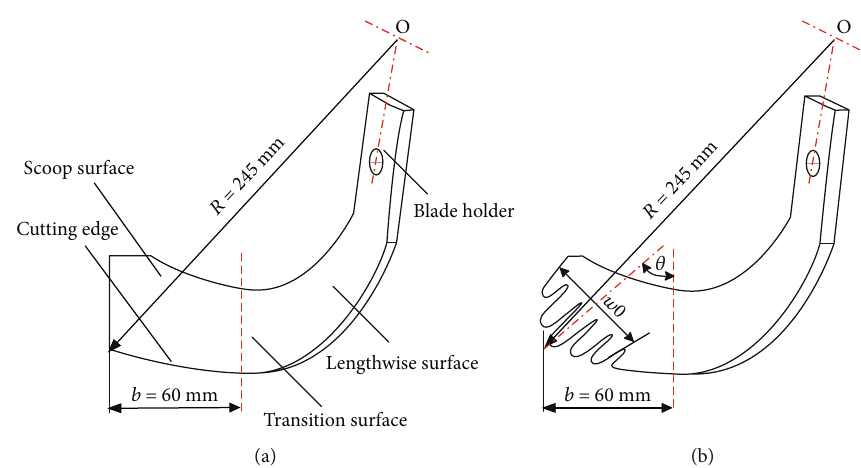
Figure 5: Con fi gurations of rotary tillage blades: (a) the conventional; (b) the biomimetic.